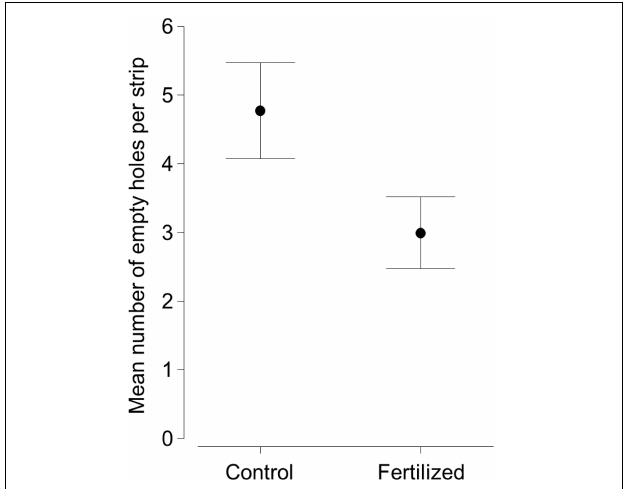
FIGURE 1 | Mean feeding activity as the mean number of empty holes per bait-lamina strip with 95% confidence intervals for the number of empty holes per bait strip in subplots without (Control; N = 72) and with (Fertilized, N = 72) experimental fertilization (Pseudo- F 140 , 4 = 18.21, P <